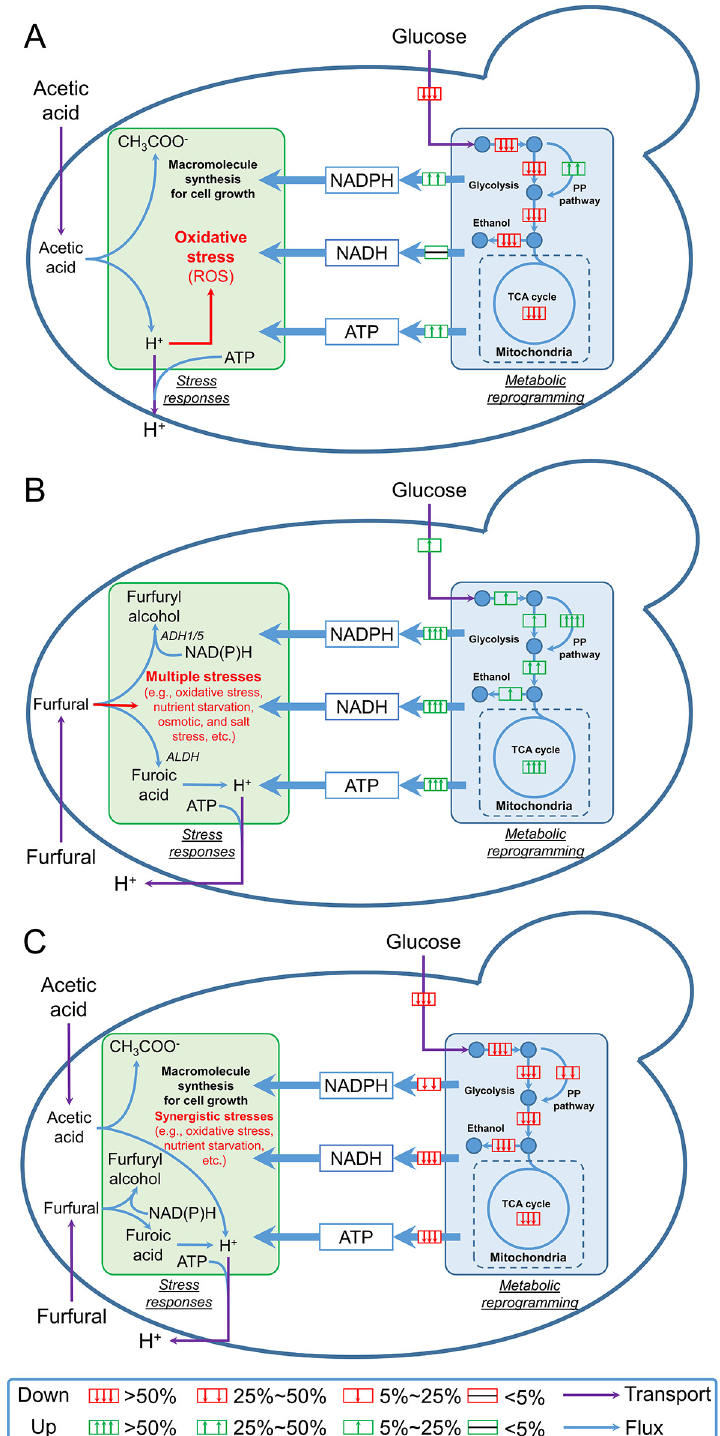
Fig 4. Generalized mechanisms used by S . cerevisiae strains in different stress conditions. (A): acetic acid stress condition; (B): furfural stress condition; (C): dual-stress condition; Abbreviations: ALDH, aldehyde dehydrogenase; ADH1/5, alcohol dehydrogenase 1/5, ROS, reactive oxygen species.